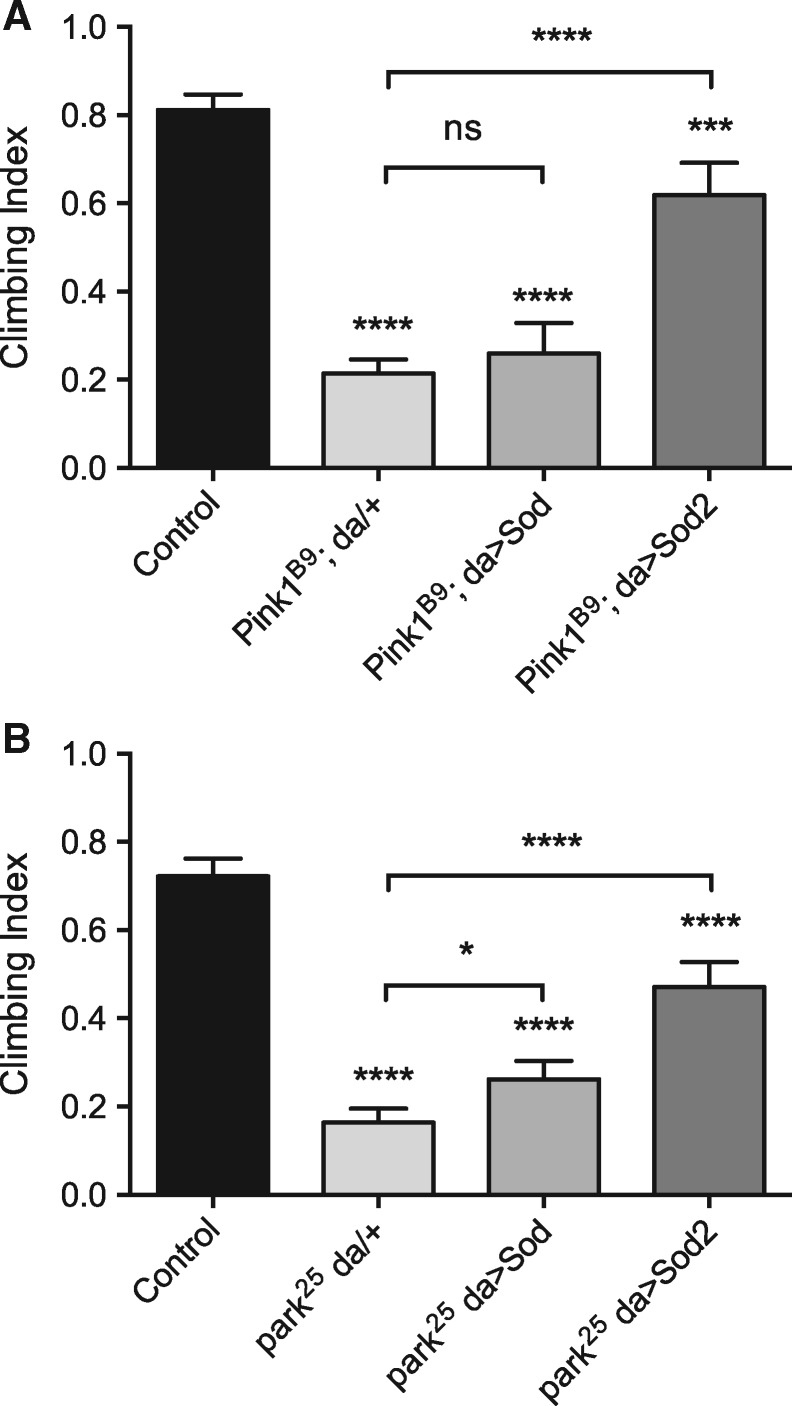
Analysis of Sod and Sod2 expression in Pink1/parkin mutant locomotor assays. Climbing assay of (A) Pink1 and (B) parkin mutant flies upon ubiquitous (da-GAL4 driver) transgenic expression of Sod or Sod2. Charts show mean and 95% CI, n > 100 animals. Statistical analysis used Kruskal–Wallis with Dunn’s multiple comparisons test (*P < 0.05, ***P < 0.001, ****P < 0.0001; ns, non-significant).